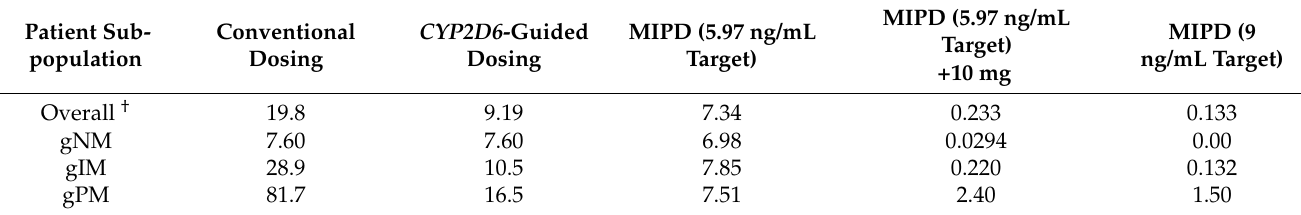
Table 1. Percentage of strictly adherent patients at risk (%) for target non-attainment.